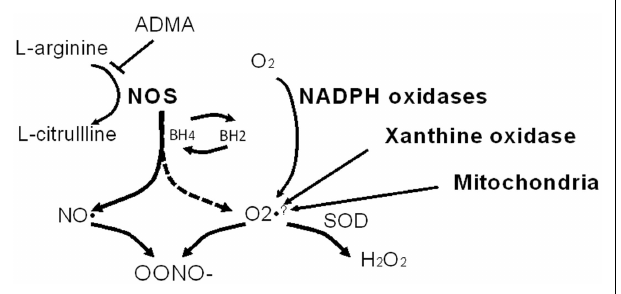
FIGURE 2 | Nitric oxide synthase (NOS) as a source of oxidants. l-arginine is the substrate for NOS and in the presence of the NOS cofactor, tetrahydrobiopterin (BH 4 ), NOS produces nitric oxide (NO).When l-arginine and/or BH 4 is/are depleted, NOS becomes uncoupled (dashed arrow) and NOS produces superoxide anion O •− at the expense of NO. Note that 2 asymmetric dimethyl arginine (ADMA) can inhibit NOS activity. NO and O •−